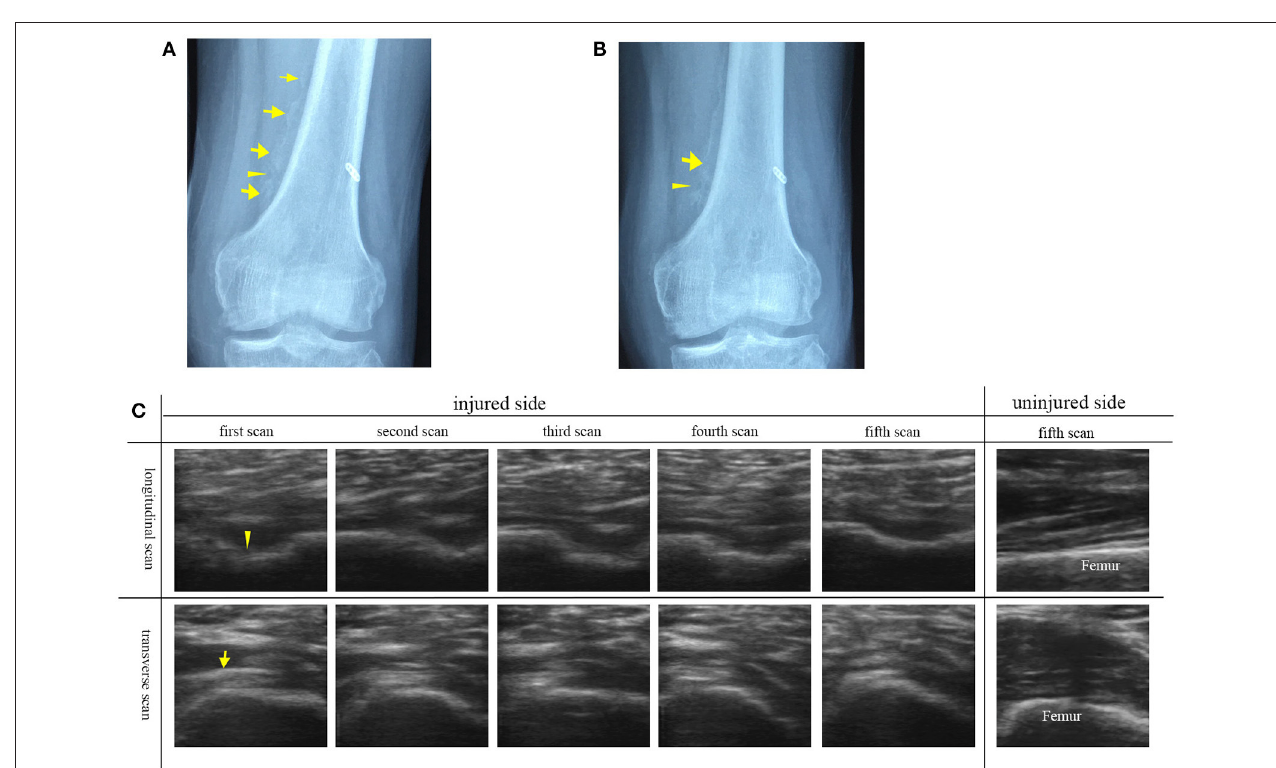
FIGURE 3 | Plain radiographs and ultrasound images of left knee joint of participant No. 8 with HO in the immature bone formation stage. (A) The plain radiograph was taken as the participant was in hospital. Discontinuous (arrowhead), faint and poorly demarcated (arrows) calcification was found. (B) The second plain radiograph was taken ∼ 1 month after the first plain radiograph. Continuous (arrowhead) and distinguishable (arrow) HO was found. (C) A series of transverse and longitudinal ultrasound images of the injured joint in comparison with the uninjured side. HO is visualized during its development. The unconnected HO tissues (arrowhead) correspond to the gap between two calcified HO tissues. On the fifth ultrasound images, the HO tissues connect smoothly to develop into the mature HO tissues. As the echogenicity and homogenesis of HO increased, the profile of the femur become blurred (arrow).